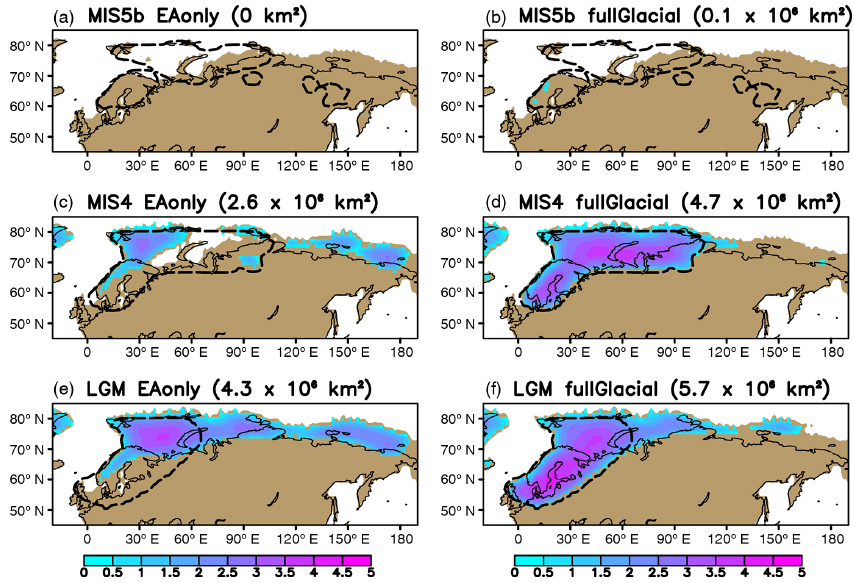
Figure 7. Simulated equilibrium ice thickness in Eurasia (shading; in km) using the PI OHT climate forcing from the EAonly (a, c, e) and fullGlacial (b, d, f) simulations for MIS5b (a, b) , MIS4 (c, d) , and the LGM (e, f) . The dashed black contours depict the outlines of the Kleman et al. (2013) ice-sheet reconstructions. The land area in the simulations is indicated by the brown color and the present-day coastline by the thin black contour. The total Eurasian ice-sheet area in each simulation is indicated in the panel titles.